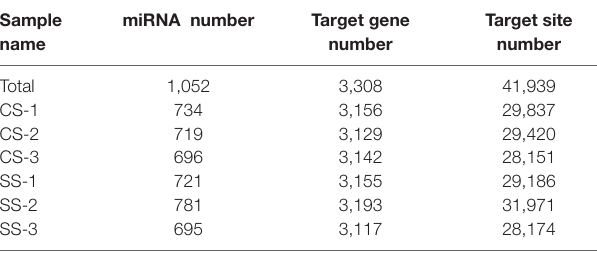
TABLE 2 | Statistics of predicted miRNAs and corresponding target